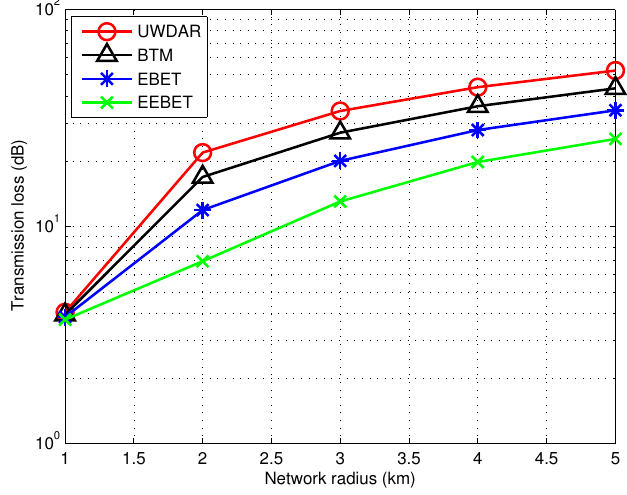
Figure 9. Comparison of transmission loss at different network